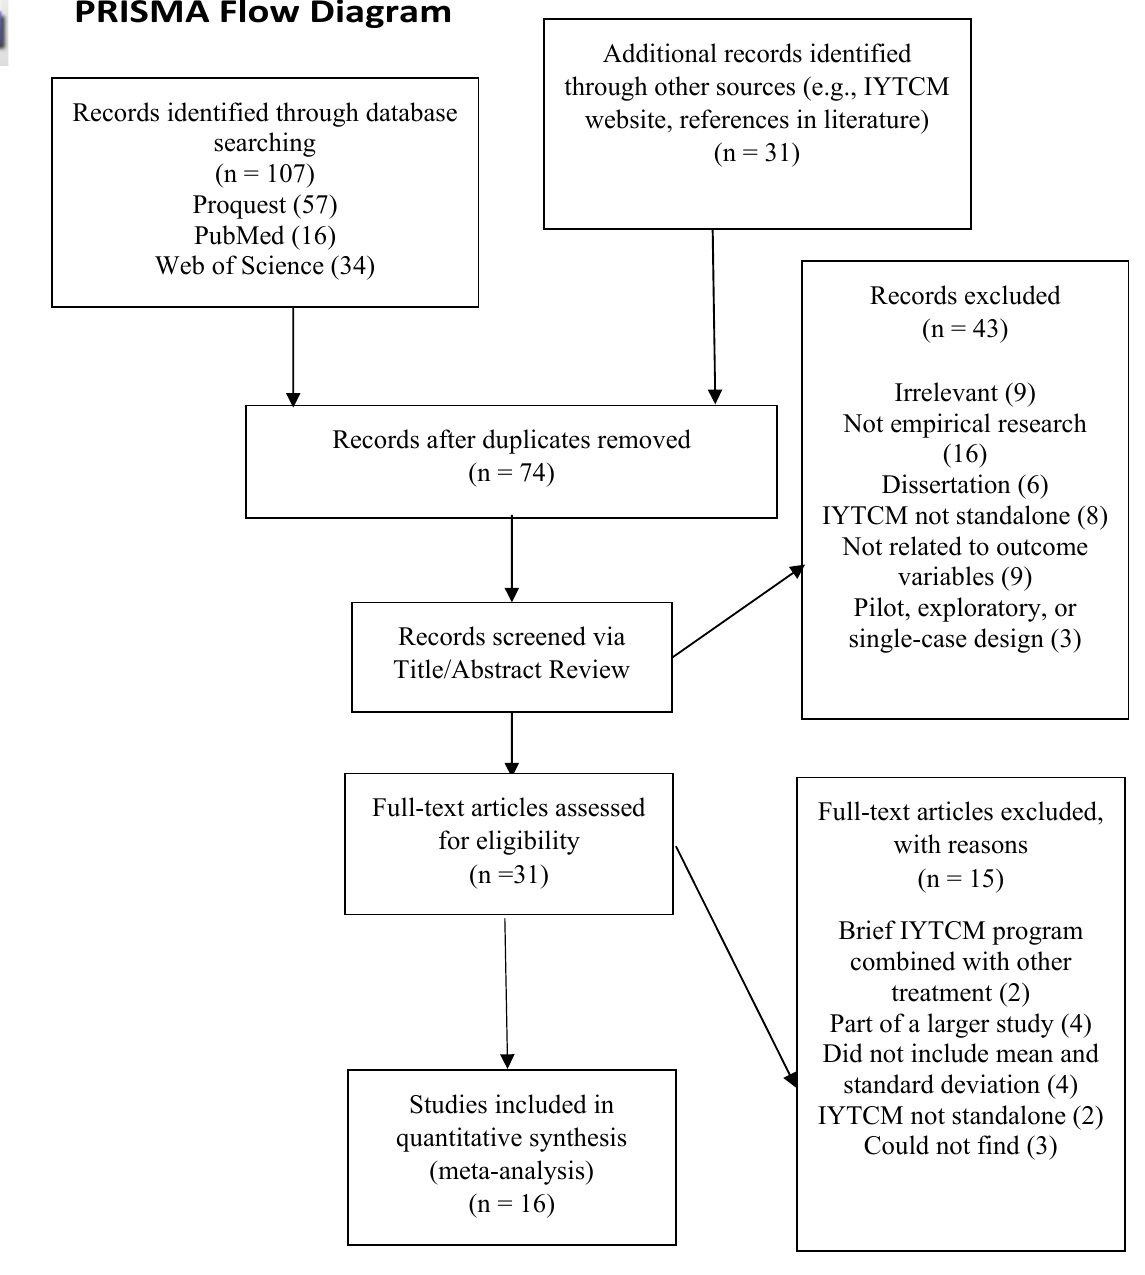
Figure 1. Preferred Reporting Items for Systematic Reviews and Meta-Analyses (PRISMA) Flow Diagram. IYTCM = Incredible Years Teacher Classroom